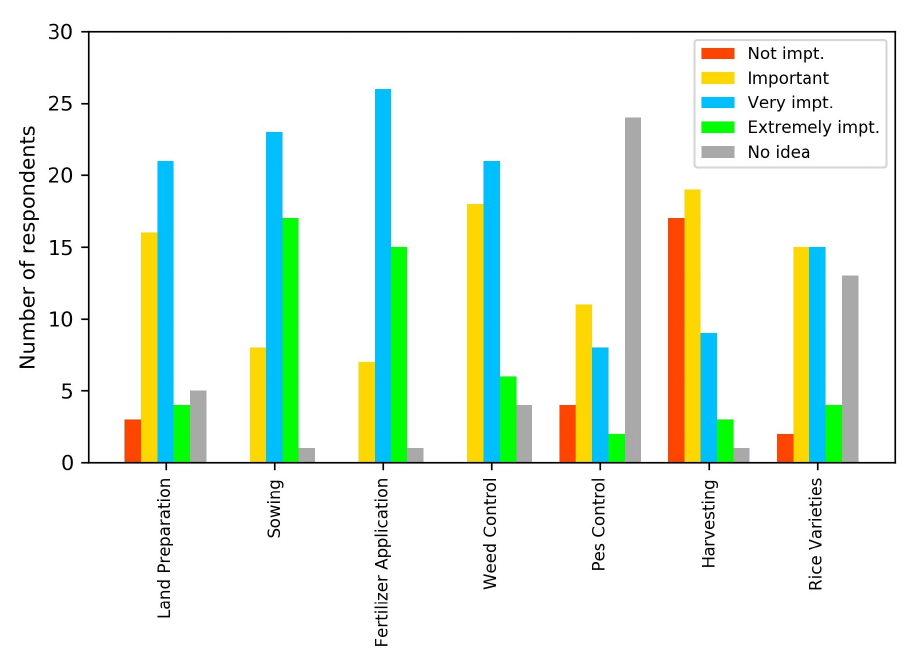
Figure 5. Farmers’ perception on the importance of soil moisture in farming decision-making stages. Acronym impt stands for important.